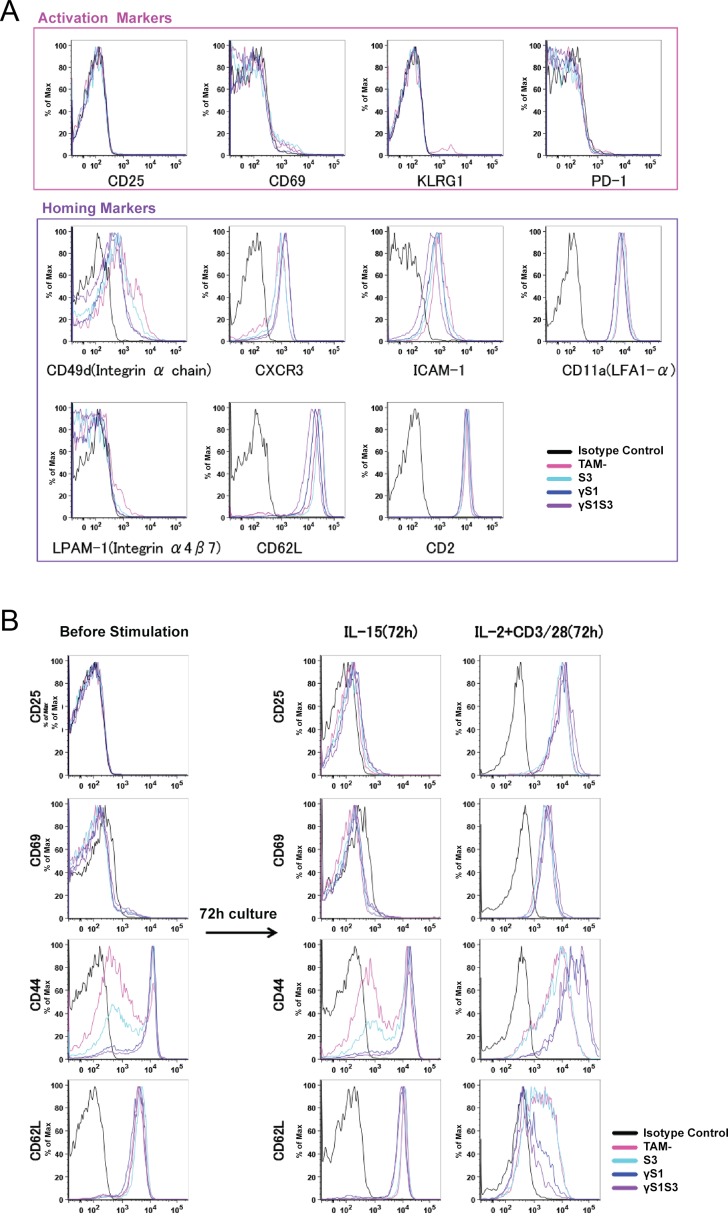
Expression of activation and homing markers on T cells from mice lacking SOCS proteins.(A) Representative flow cytometry profiles showing expression of activation and homing markers as indicated on CD8+ CD44high cells from spleens of mice 14d after tamoxifen or vehicle treatment. (B) CD8+ T cells were purified from spleens of mice 14d following tamoxifen or vehicle treatment. The cells were stimulated for 72 hours in culture in the presence of IL-15 or IL-2 plus anti-CD3/CD28. Expression of CD25, CD69, CD44 and CD62L before and after culture in a representative experiment is shown.